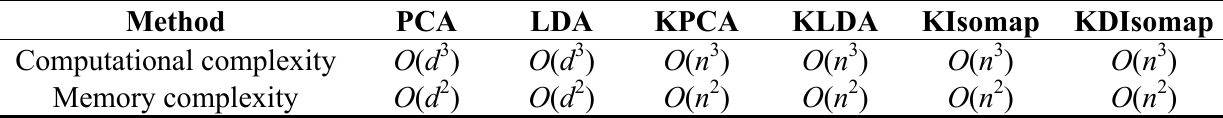
Table 5. Computational and memory complexity of different dimensionality reduction